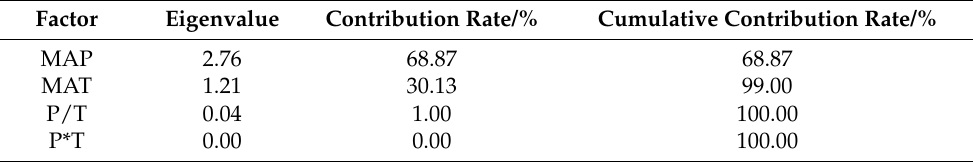
Table 3. Eigenvalues and contributions of principal components.